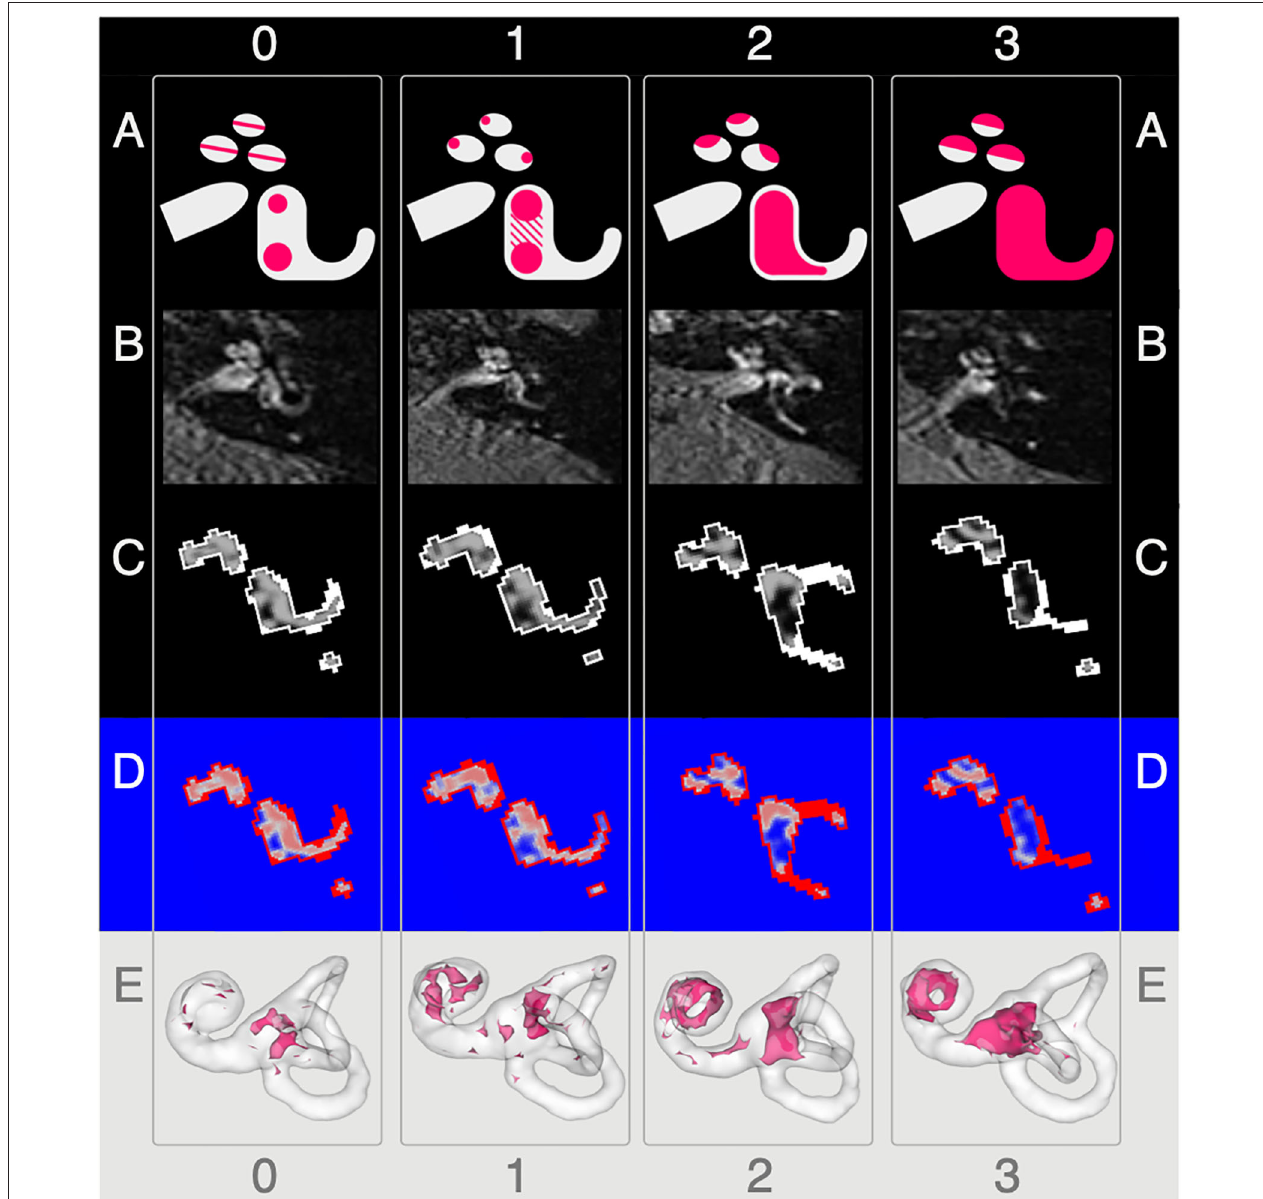
FIGURE 1 | Semi-quantitative (SQ) grading used for the endolymphatic hydrops. The vertical columns show the different semi-quantitative (SQ) grades from 0 to 3 used [cf. Table 1 ; according to a classification first described in Kirsch et al. (9)]. The horizontal rows each give an overview of how each grade looks (A) , in FLAIR raw data (B) , after VOLT processing (C) , as used for 2D quantification (D) , and as used for 3D quantification (E) . A detailed description of each grade is given in the second paragraph of subsection ‘Semi-quantitative Grading of the Endolymphatic Space’.